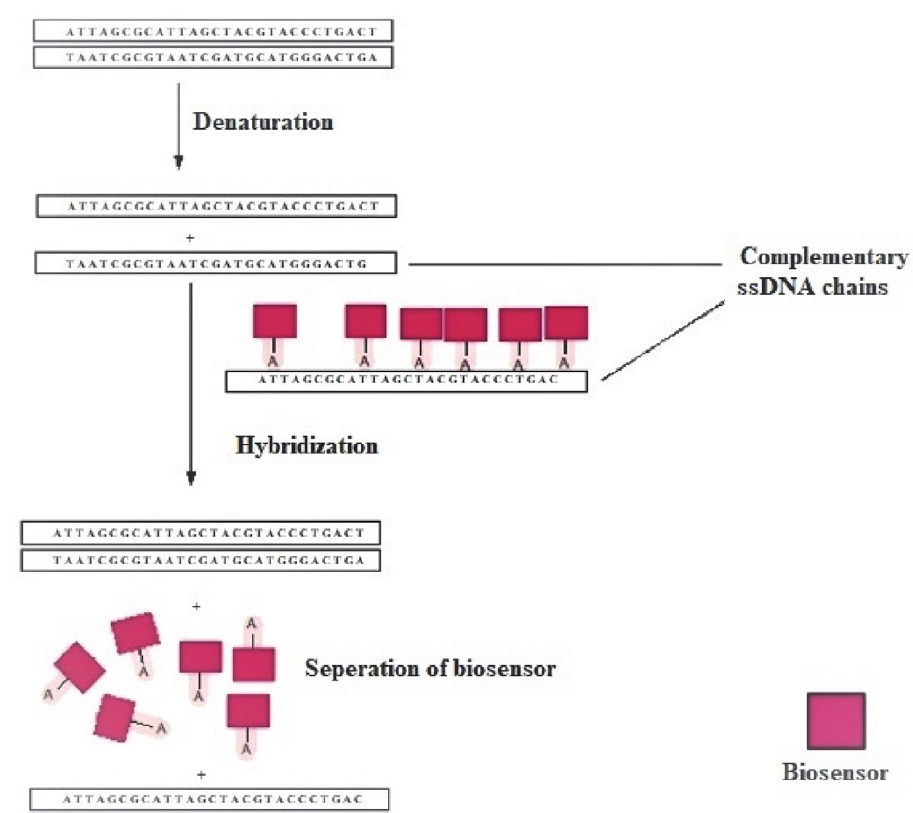
Figure 1. Separation of the biosensor from the hybrid complex with the matching of complementary